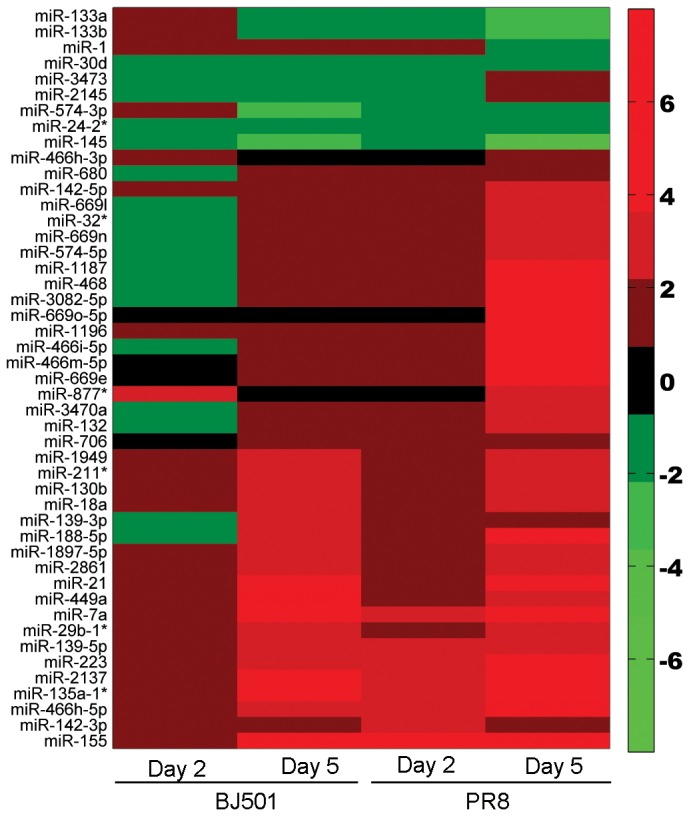
Distinct cellular microRNA expression patterns during influenza virus BJ501 and PR8 infections.The columns correspond to expression patterns of differentially expressed microRNAs during the influenza virus BJ501 and PR8 infections relative to mock-infected samples on 2 dpi and 5 dpi. Significance was determined using a fold-change threshold of at least 2 and a P value cutoff of 0.05. The red color represents up-regulation, while the green color indicates down-regulation.